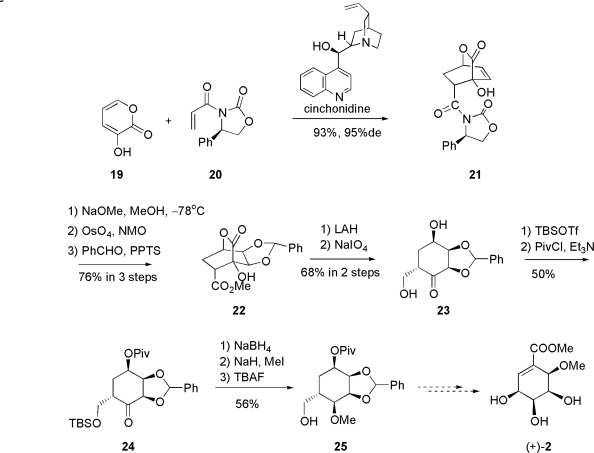
Okamura’s approach.